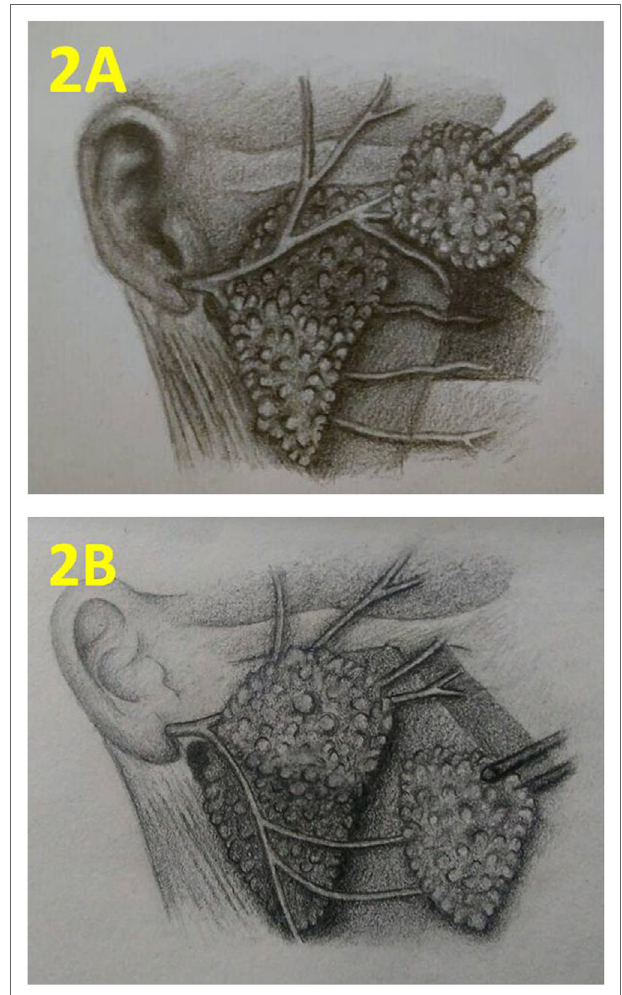
FigUre 2 | Schematic presentation of the technique. (a) Upper quadrantectomy. (B) Lower quadrantectomy. Courtesy of Manar Adel; with kind permission.